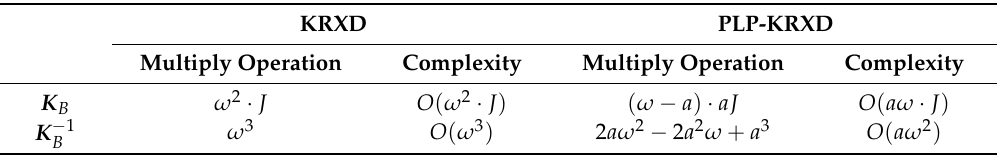
Table 2. Computational complexity of KRXD and PLP-KRXD.